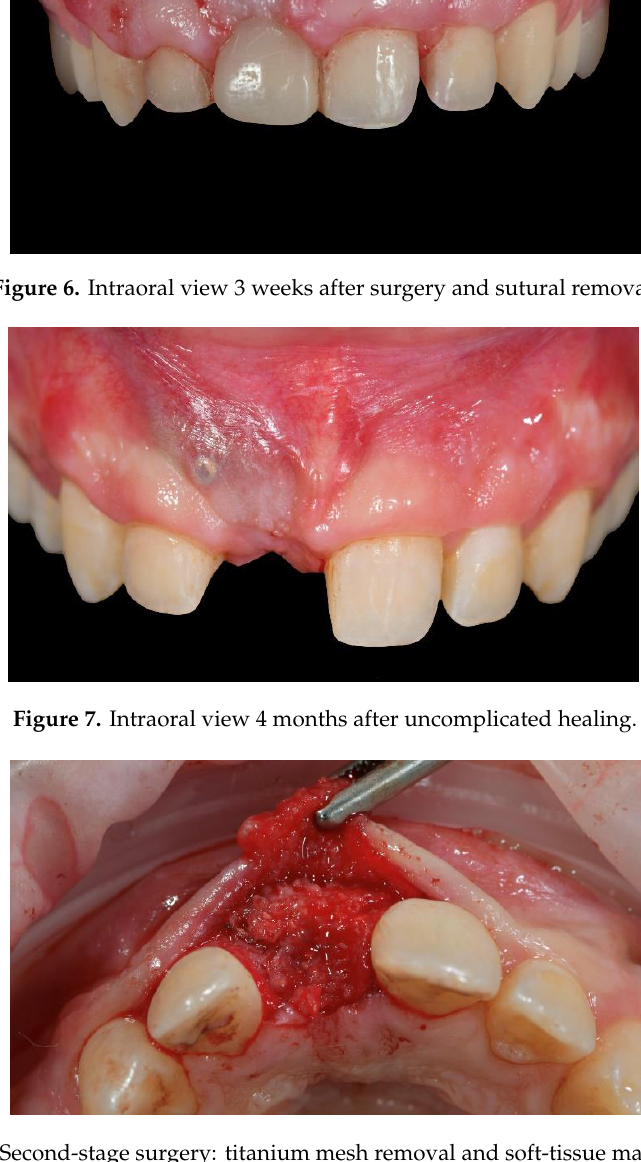
Figure 9. Intraoral view 3 months after second-stage surgery.